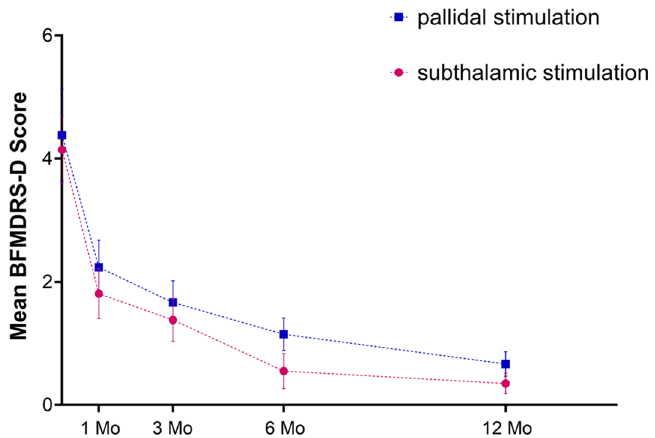
Figure 2. Burke–Fahn–Marsden Dystonia Rating Scale disability subscale scores (BFMDRS-D; scores range from 0 to 30, with higher scores indicating greater impairment) at baseline and throughout the 12-month study period. There was no between-group differences in the mean changes in BFMDRS-D scores based on the stimulation target. I bars indicate the standard error of the mean.